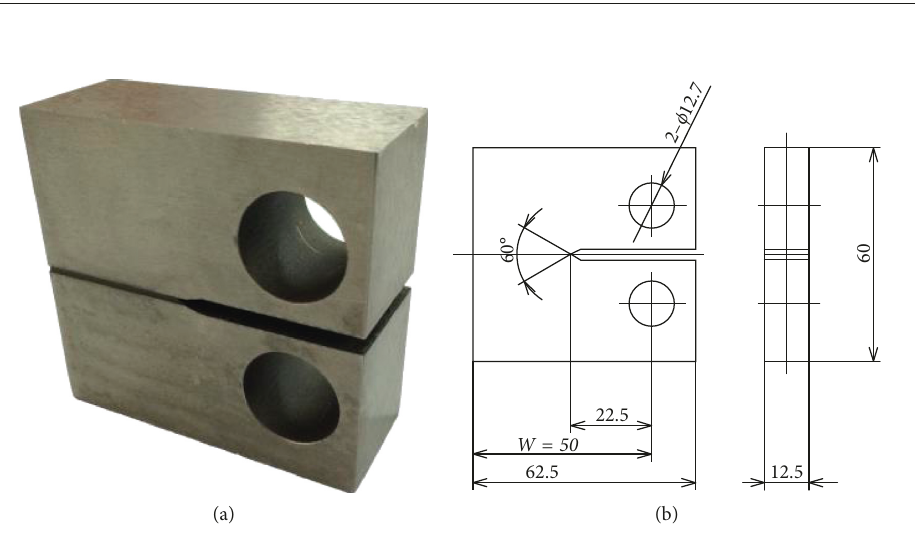
Figure 1: Compact tension specimen: (a) specimen; (b) geometric dimensioning.